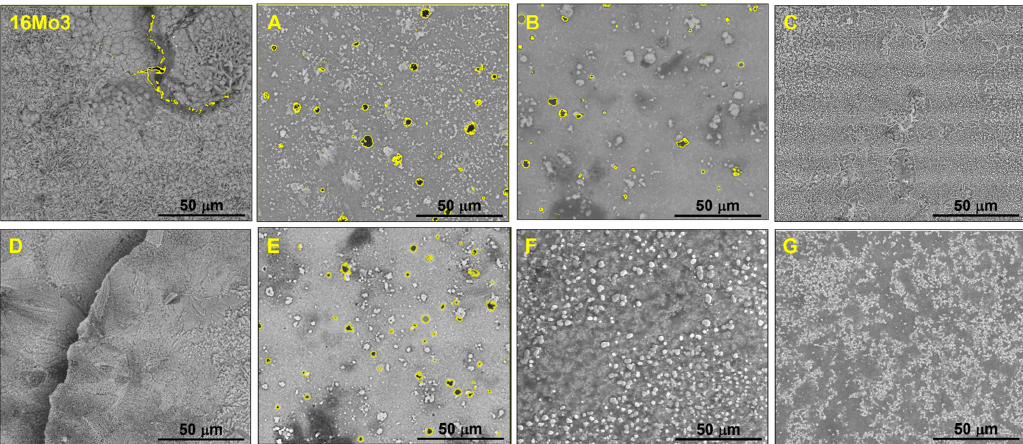
Figure 5. SEM images of the surfaces of uncoated 16Mo3 and coated samples (( A – G ) coatings) ex- posed at 650 °C for 48 h in Ar-10%H 2 O atmosphere (pores and cracks are highlighted in yellow). Note that there were no oxide scales formed at the top of the enamel coatings.